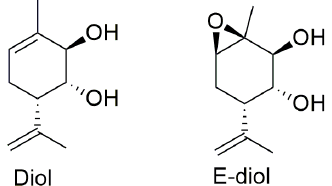
Figure 1. Structures of Diol and E-diol.